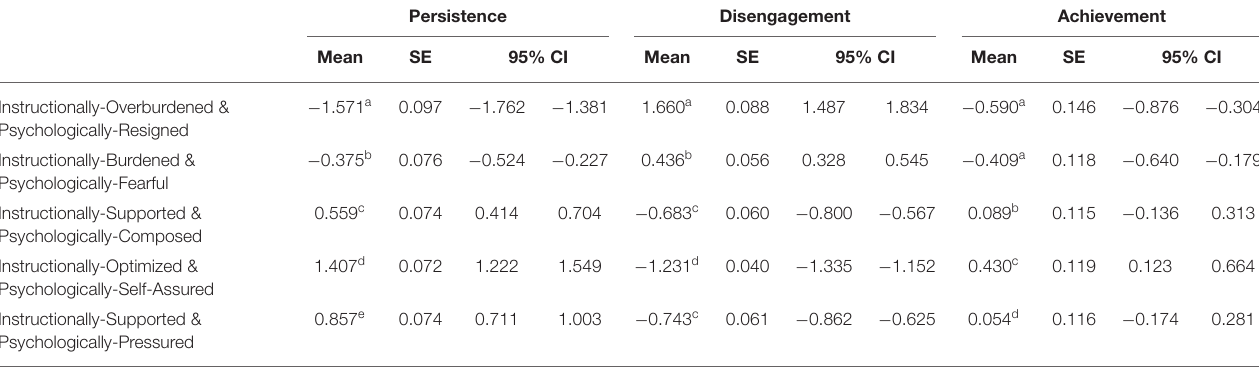
TABLE 3 | Means (SEs and 95% CIs) on dependent variables for each instructional-psychological profile. Persistence Disengagement Achievement Mean SE 95% CI Mean SE 95% CI Mean SE 95%